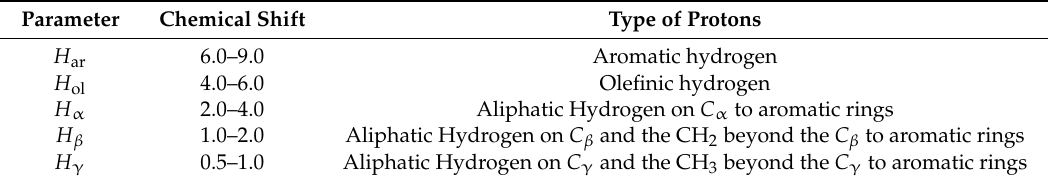
Table 2. Types of protons and chemical shift assignments [25].